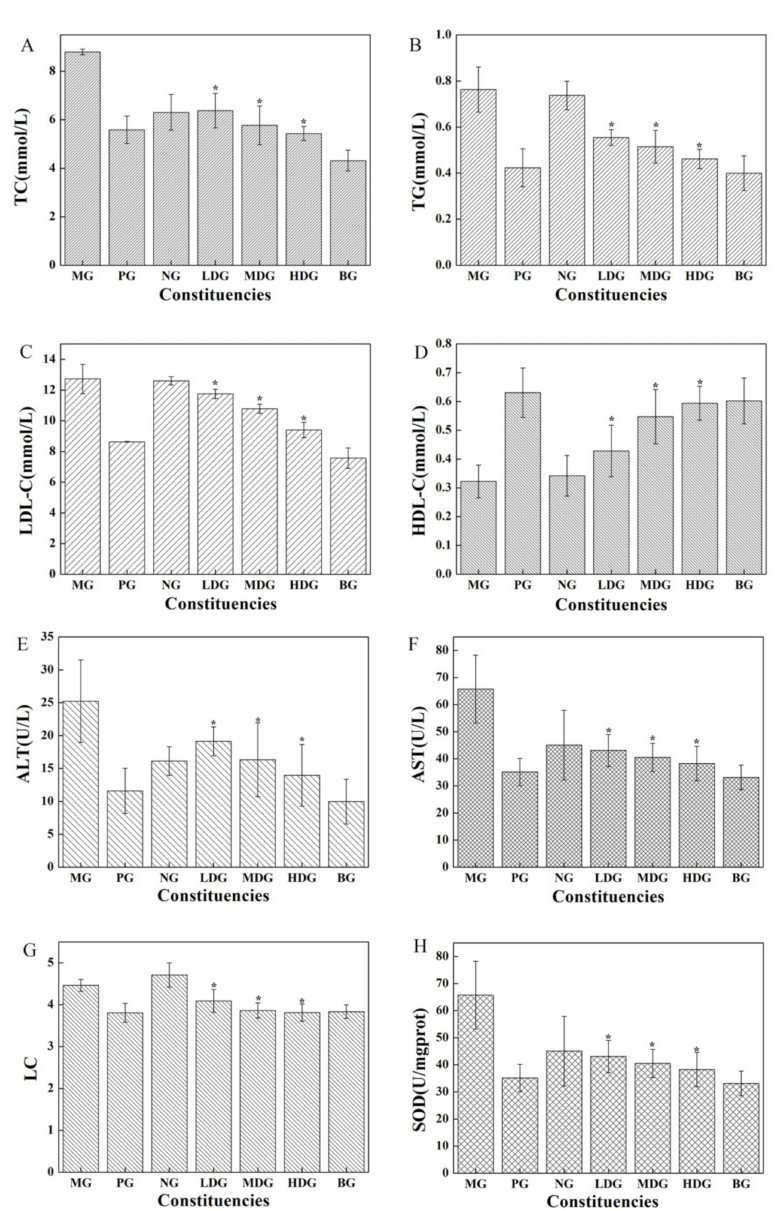
Figure 6. TC ( A ), TG ( B ), LDL-C ( C ), HDL-C ( D ), ALT ( E ), AST ( F ), LC ( G ), and SOD ( H ) levels in mice. * p < 0.05 as compared with